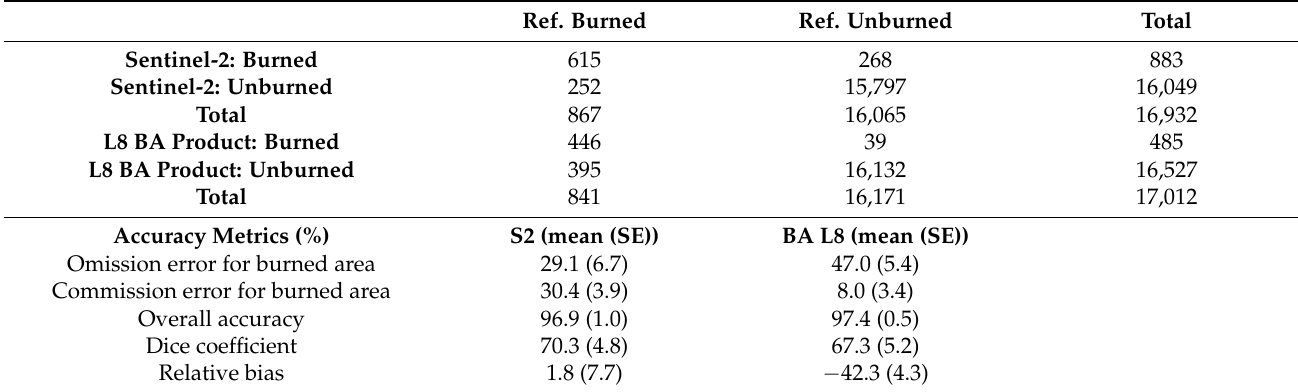
Table 3. Accuracy of Sentinel-2 (S2) burned area as validated from WorldView-2 and WorldView-3 imagery. The top part of table shows the agreement of validation points by count, while the bottom part of the table presents accuracy statistics. Accuracy statistics for the burned area (BA) product, derived from Landsat-8 (L8) only, also provided for comparison purposes. Standard errors (SE) for accuracy metrics in parentheses. Ref. =